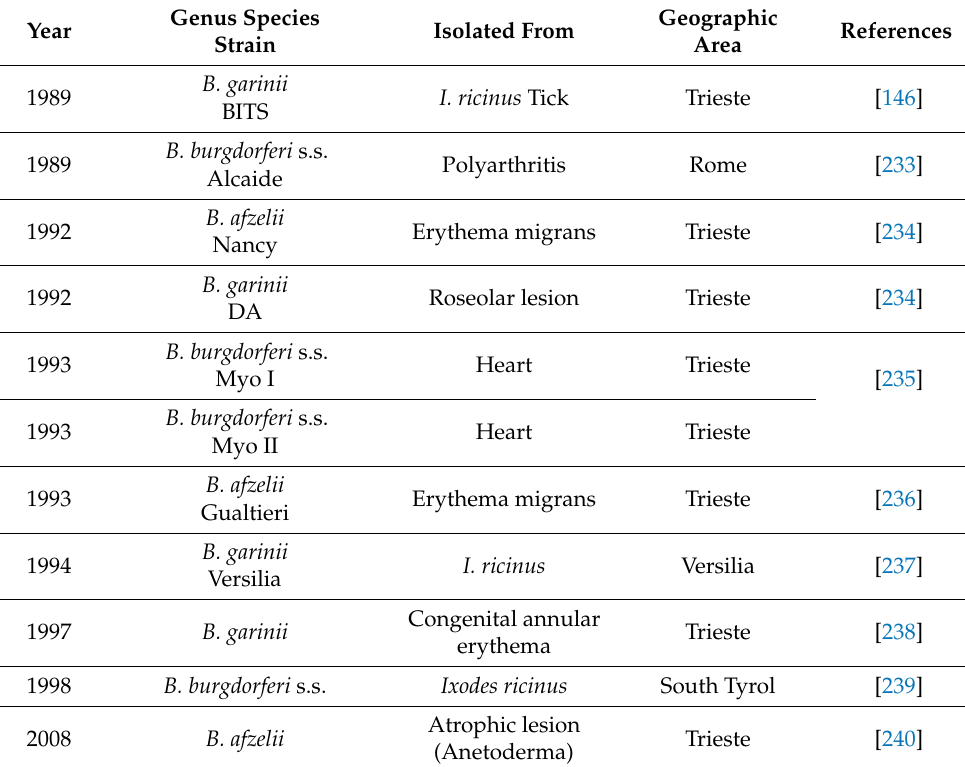
Table 7. Borrelia burgdorferi sensu lato strains isolated in